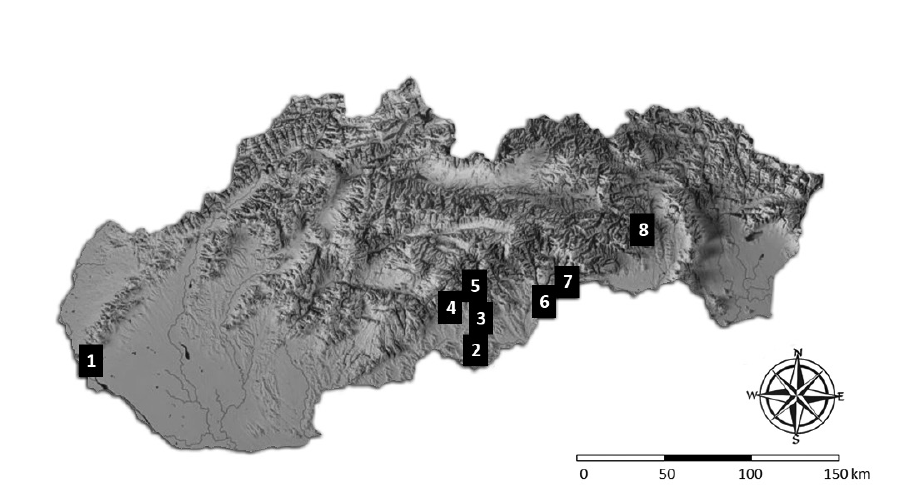
Figure 1. Location of the study sites. 1/ Borinka (Malé Karpaty Mts.), 2/ Belinské skaly (Cerová vrchovina Highlands), 3/ Drienok Valley, 4/ Slope next to the Malá drienčanská Cave, 5/ Collapse above the Veľká drienčanská Cave (three sites are in the Revúcka vrchovina Highlands), 6/ Vysoký vrch Hill, 7/ Doline next to Silická ľadnica Ice Cave (both sites in Slovak Karst), 8/ Malý Ružinok Valley (Čierna hora Mts.).